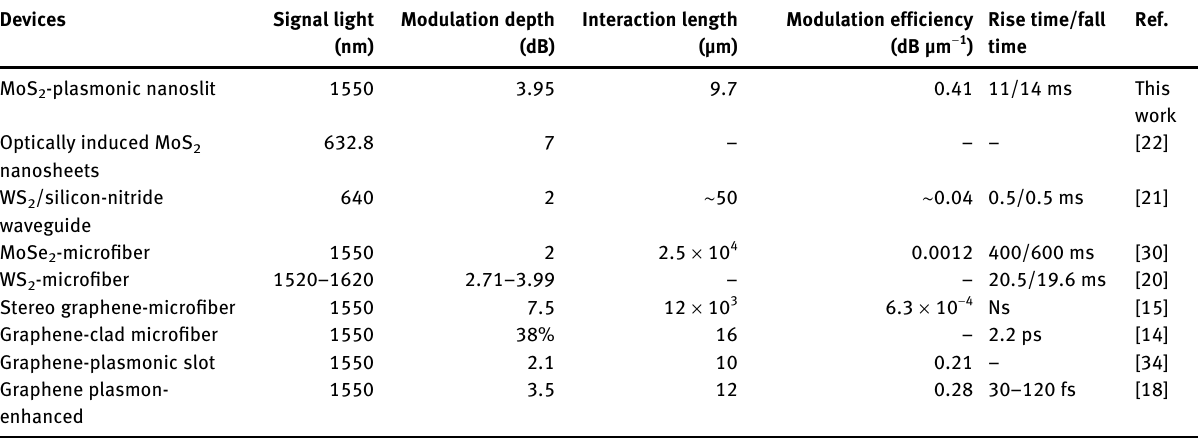
Table  :  D material-based all-optical modulators. Devices Signal light Modulation